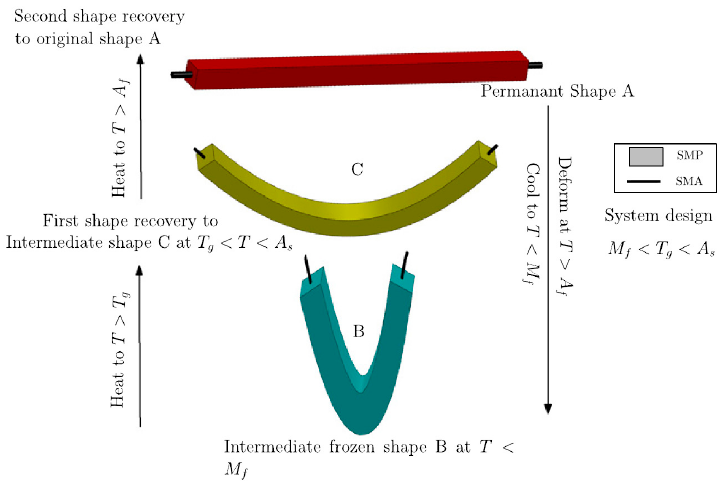
Figure 8. Three-state configuration (triple-shape memory) obtained by SMEP and SMA wire ([178], reproduced with permission from Elsevier). Note: for designations see Figure 7.